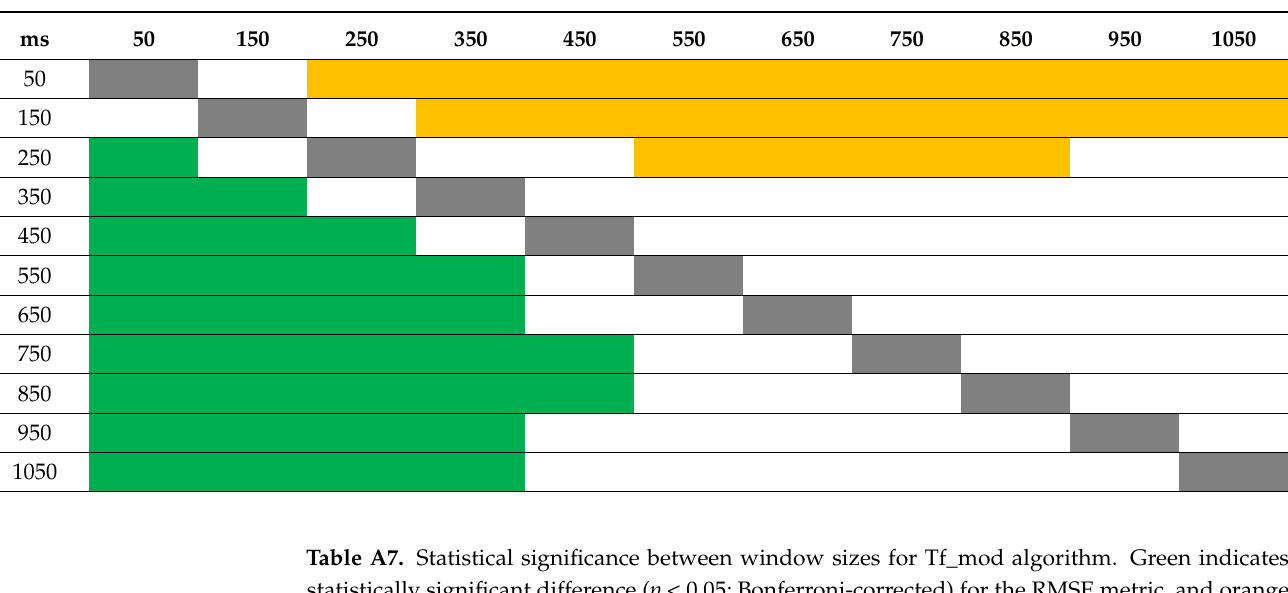
statistically significant difference ( p < 0.05; Bonferroni-corrected) for the RMSE metric, and orange